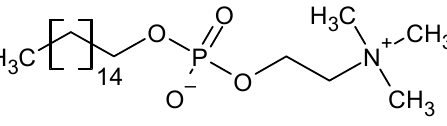
Figure 13. The structural formula of miltefosine .